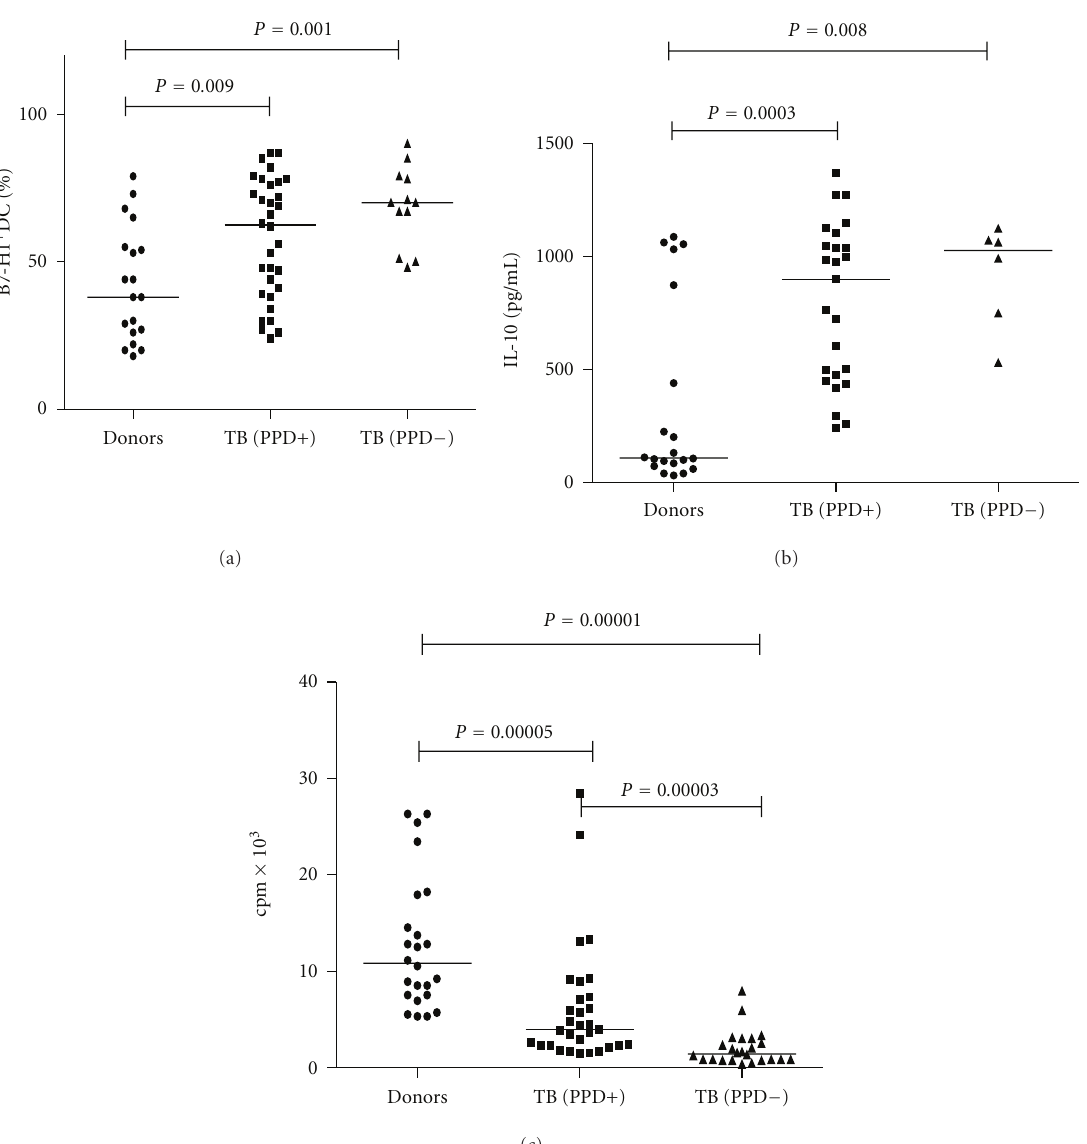
Figure 1: Expression of B7-H1 and production of IL-10 by patient DCs was higher, but their allostimulatory activity was lower than that of healthy donor DCs. (a) The expression of B7-H1 on the DCs in healthy donors ( n = 19), PPD-reactive TB patients (PPD+; n = 32), and PPD-anergic TB patients (PPD − ; n = 12) was detected by flow cytometry using anti-B7-H1 monoclonal antibodies. (b) The production of IL-10 by DCs was determined by ELISA in healthy donors ( n = 20), PPD-reactive ( n = 25) and PPD-anergic TB patients ( n = 6). (c) The allostimulatory activity of DCs in MLC was detected in healthy donors ( n = 24), PPD-reactive ( n = 32), and PPD-anergic TB patients ( n = 24). The median value was presented for each investigated group.